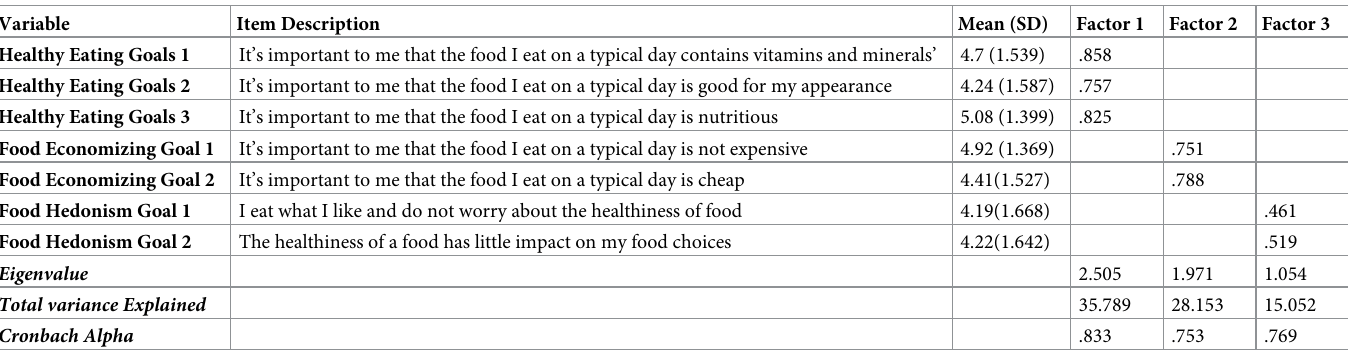
Table 4. Factor analysis